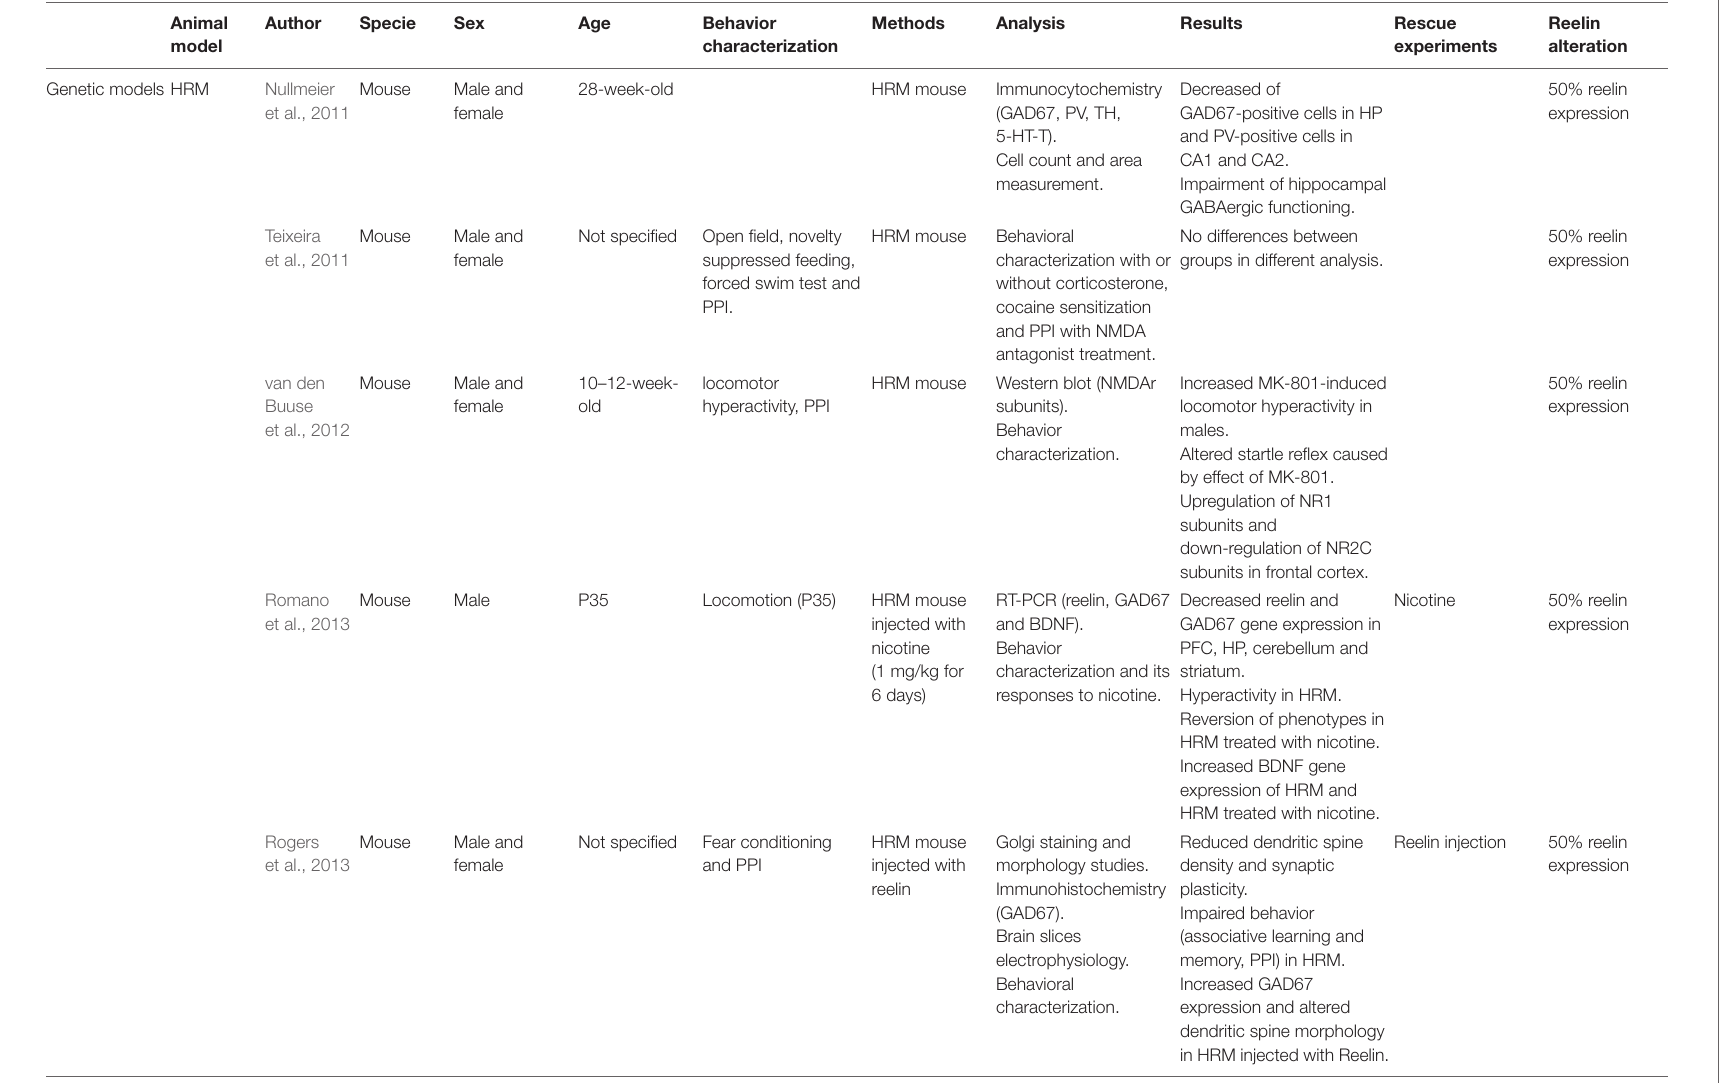
TABLE 4 | Principal findings of genetic model studies included in this